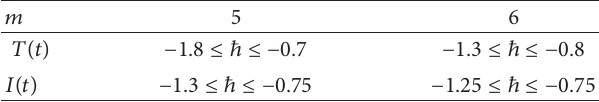
Table 2: The admissible value of ℏ derived from Figures 2 and 3.